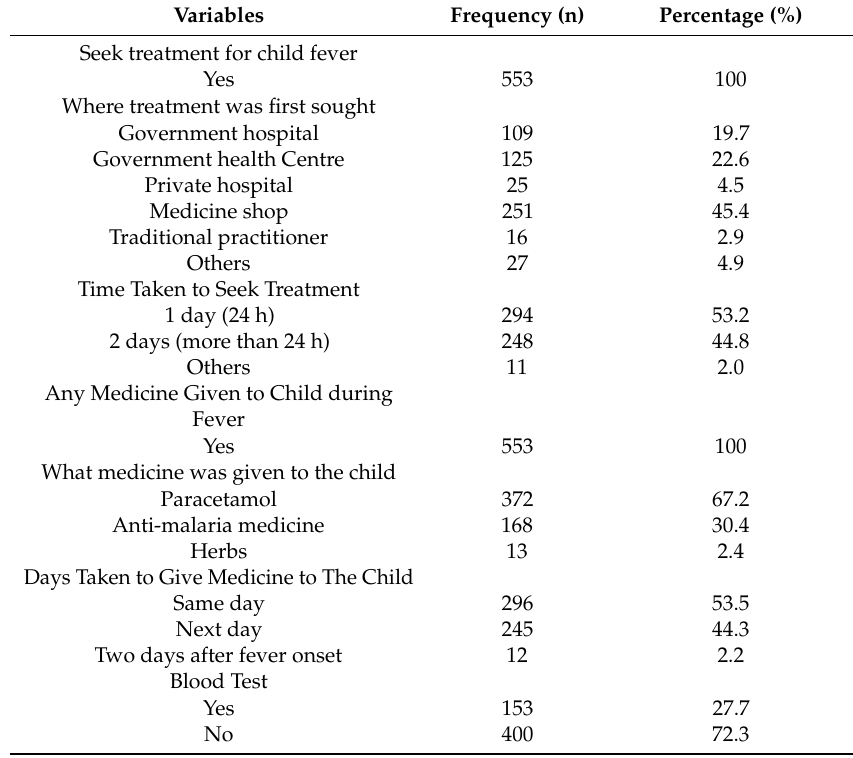
Table 2. Caregivers’ health seeking behavior (N =